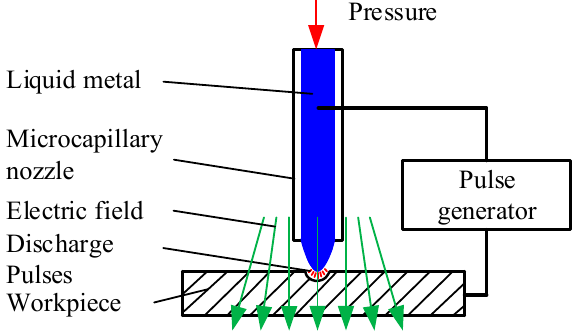
Figure 1. Principle of micro-electro-discharge machining ( µ EDM) using a liquid-metal electrode.